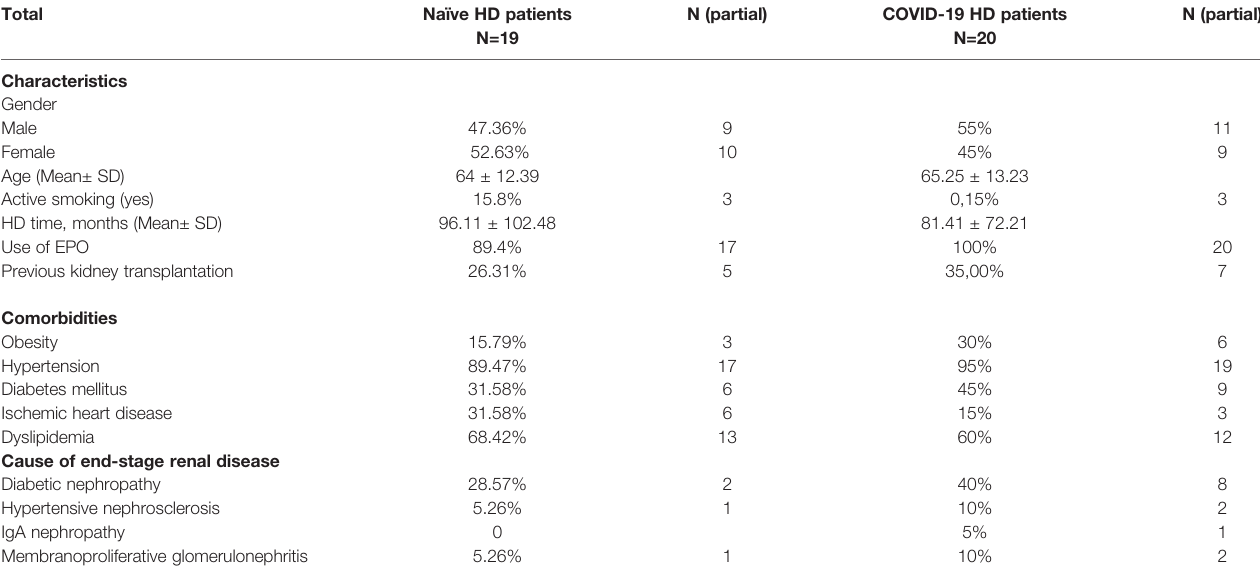
TABLE 1 | Naïve and COVID-19 recovered HD patients on long-term hemodialysis present similar characteristics, except for diabetic nephropathy as a cause of end- stage renal disease and smoking.